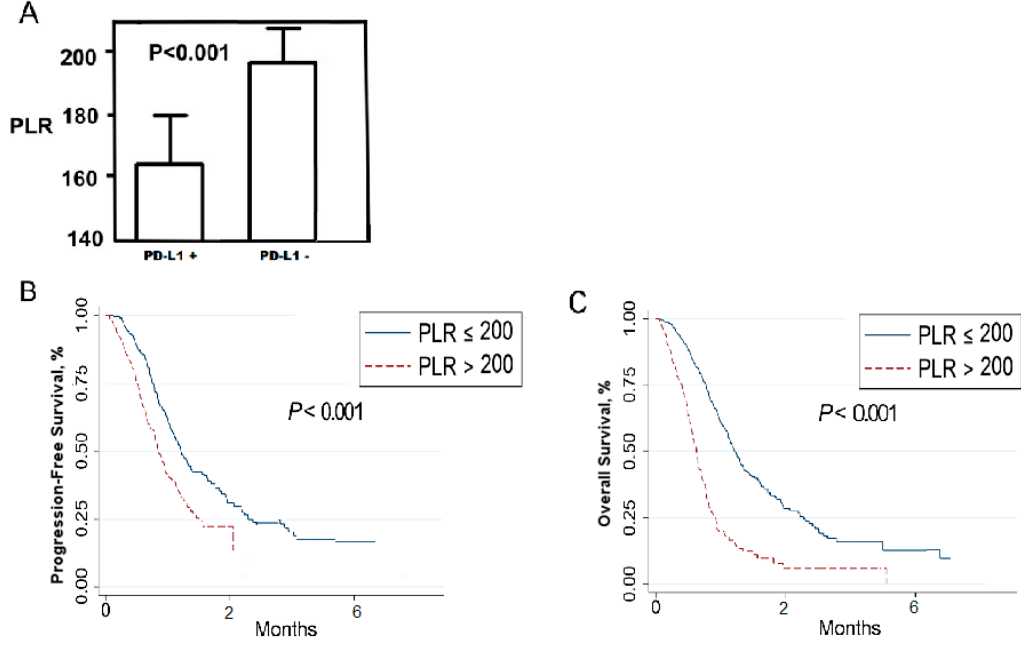
Figure 5. Relationship between PLR and PD-L1 +/ − CTCs ( A ): patients with PD-L1 + CTCs had lower PLR. Patients treated with regorafenib in the PLR-low group had a better PFS ( B ) and OS ( C ) compared to patients in the PLR-high